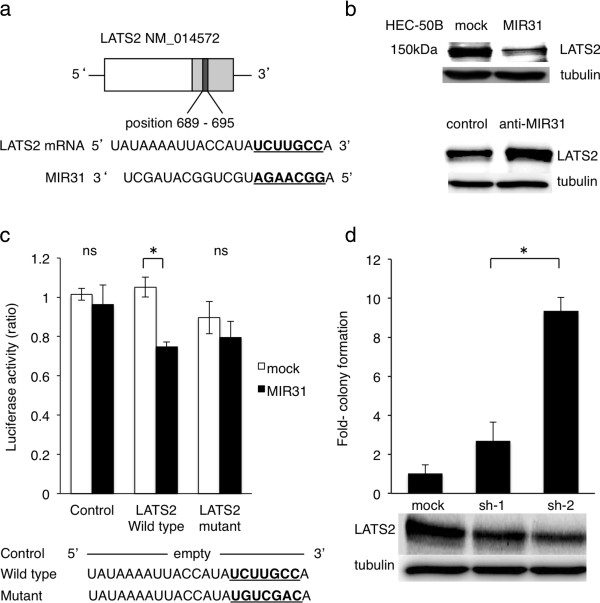
MIR31 regulates the LATS2 expression by inhibiting translation. (a) The potential binding site for MIR31 in 3’UTR of LATS2 mRNA. (b) The expression level of LATS2 in the mock and MIR31-overexpressing cells (top). The LATS2 expression was increased by the MIR31-specific inhibitor (bottom). The results of immunoblotting for LATS2 and α-tubulin are shown. (c) The luciferase activity after transfection of the indicated 3’-UTR-driven reporter constructs. Reporter plasmids containing no oligonucleotides as a Control, the wild-type 3’UTR region of LATS2 as a Wild type and the mutant 3’UTR region as a Mutant. *p < 0.05, unpaired two-tailed Student’s t-test. (d) Colony formation assay (bar graph) and immunoblotting for LATS2 and α-tubulin following shRNA transfection (bottom panel). *p < 0.05, unpaired two-tailed Student’s t-test. All experiments were performed in triplicate.